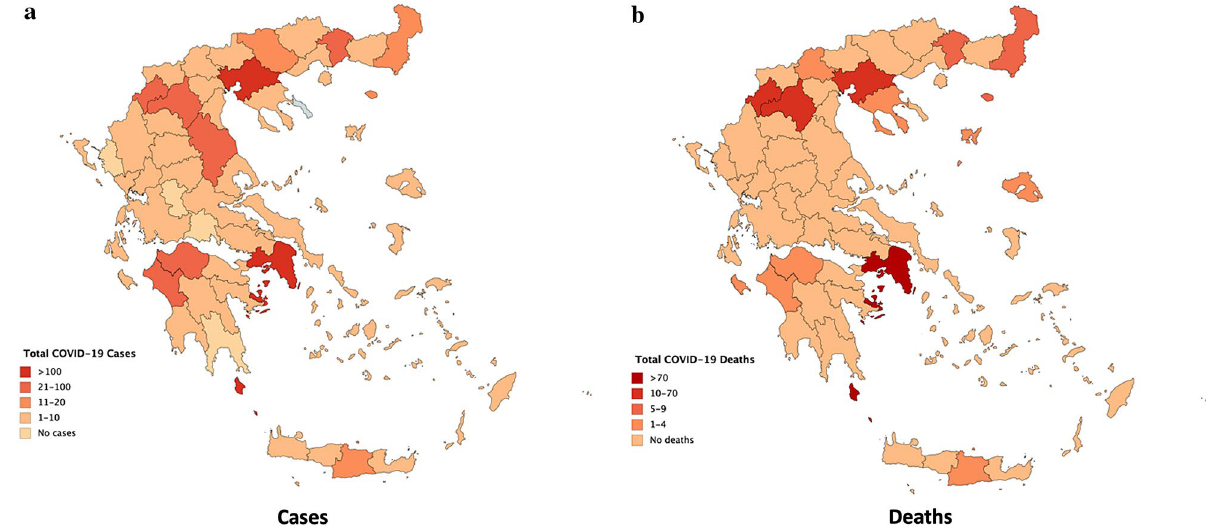
Figure 3. Cumulative COVID-19 ( a ) cases and ( b ) deaths in Greece as of May 3rd (Mapcharts 23